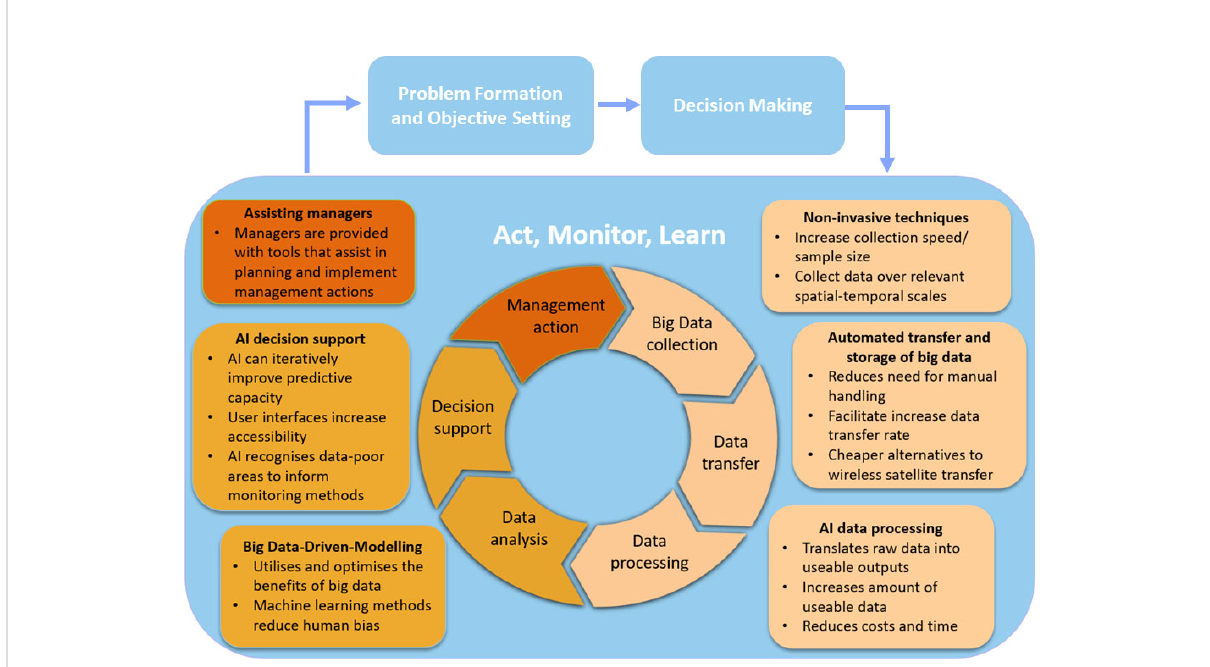
FIGURE 2 Conceptual, cyclical diagram for the capacity for an automated system to support managers at all stages, from baseline data collection to objective setting, to ongoing long-term monitoring and management actions. We summarise the main points in each step where managers may bene fi t from implementing an automated system to assist in achieving management outcomes. Automation and AI technology can assist managers in learning about the environment to support problem formation and inform objective setting, as well as assist in ongoing, high- resolution monitoring to inform on the results of management